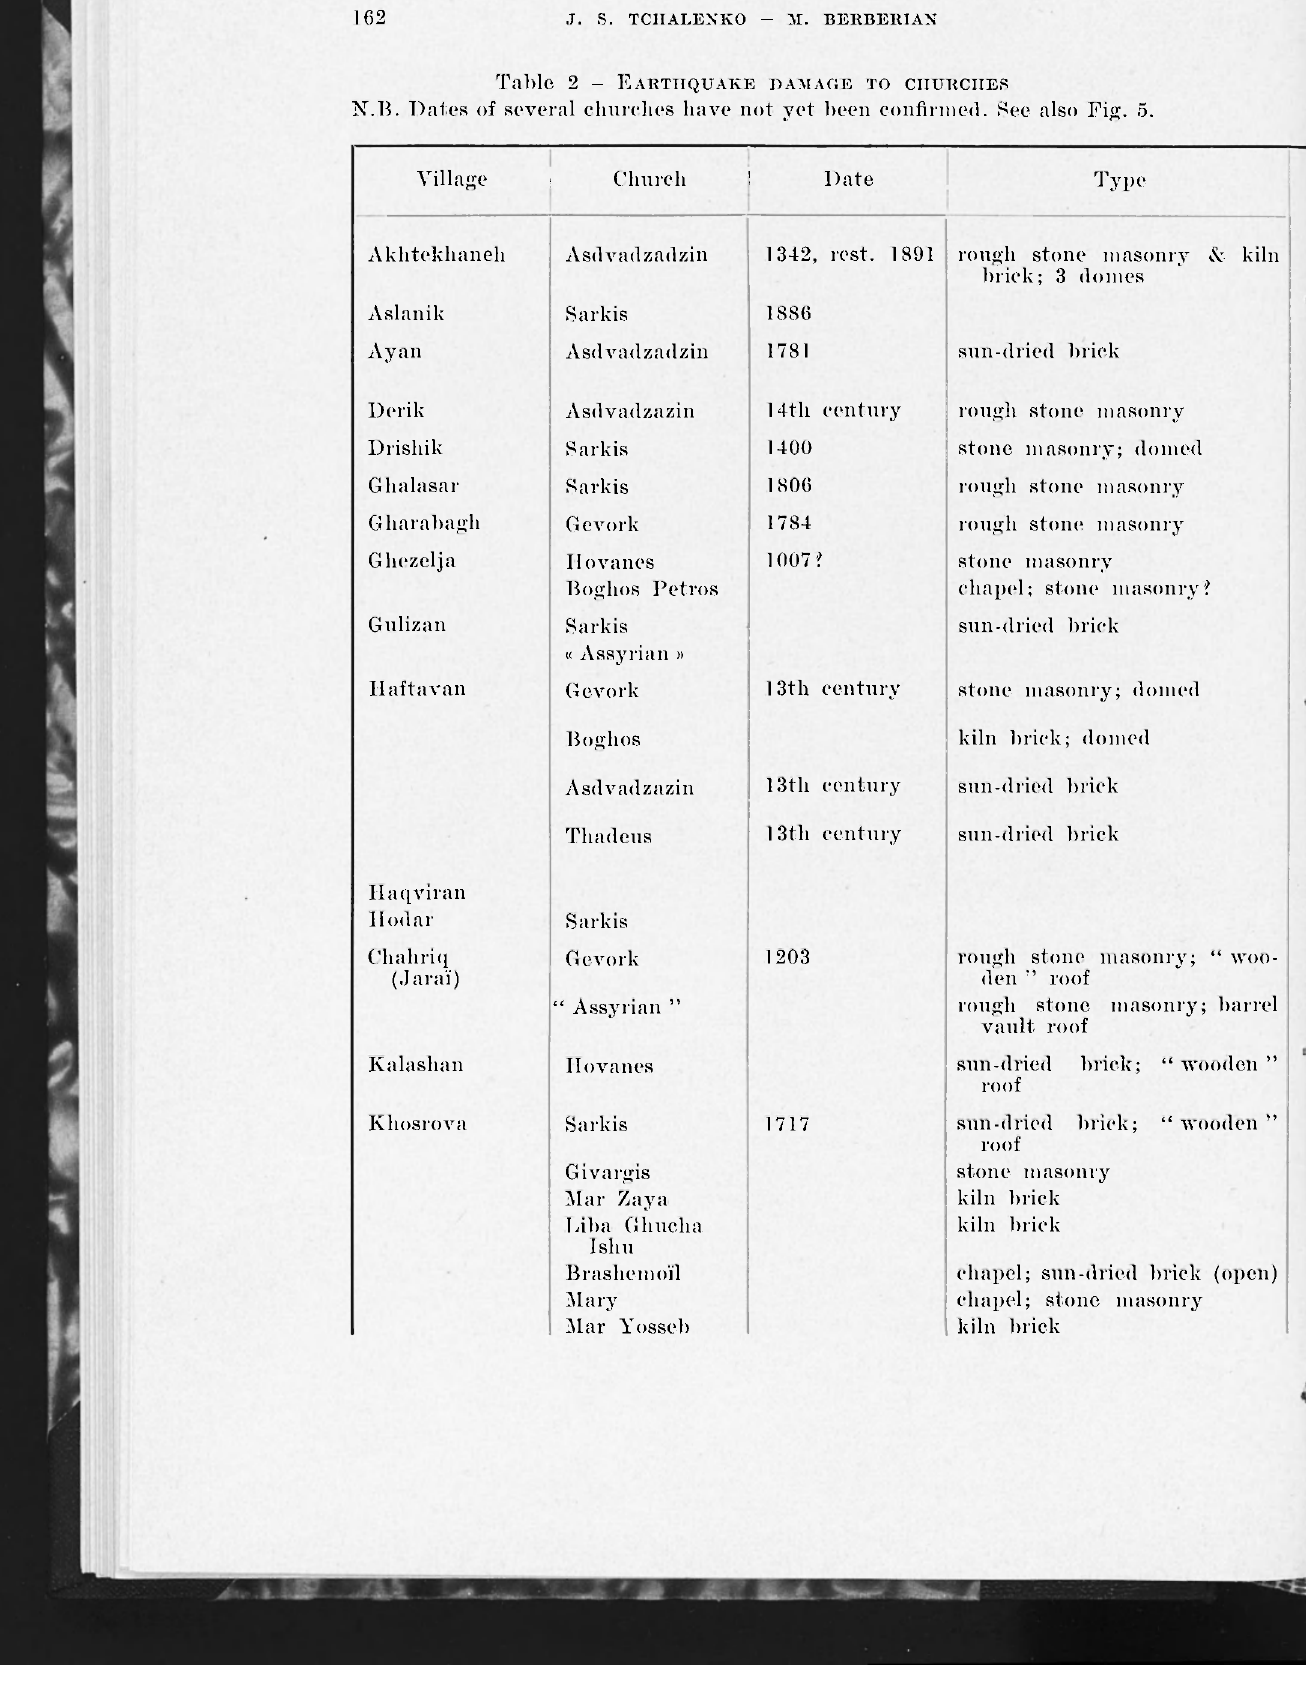
Table 2 - EARTHQUAKE DAMAGE TO CHURCHES Ji.B. Dates of several churches have not yet been confirmed. See also Fig.